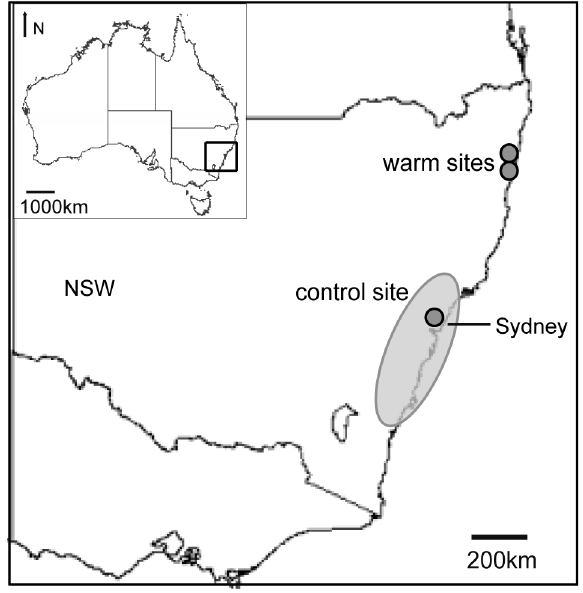
Figure 1. Location of three transplant sites. One control site within the current range of eight host plant species (grey oval); and two warm sites, located ca. 600 km north of the northern boundary of the plant species’